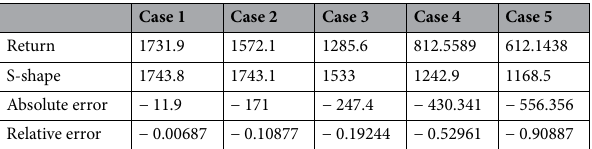
Table 7. Model results of the two routing strategies.